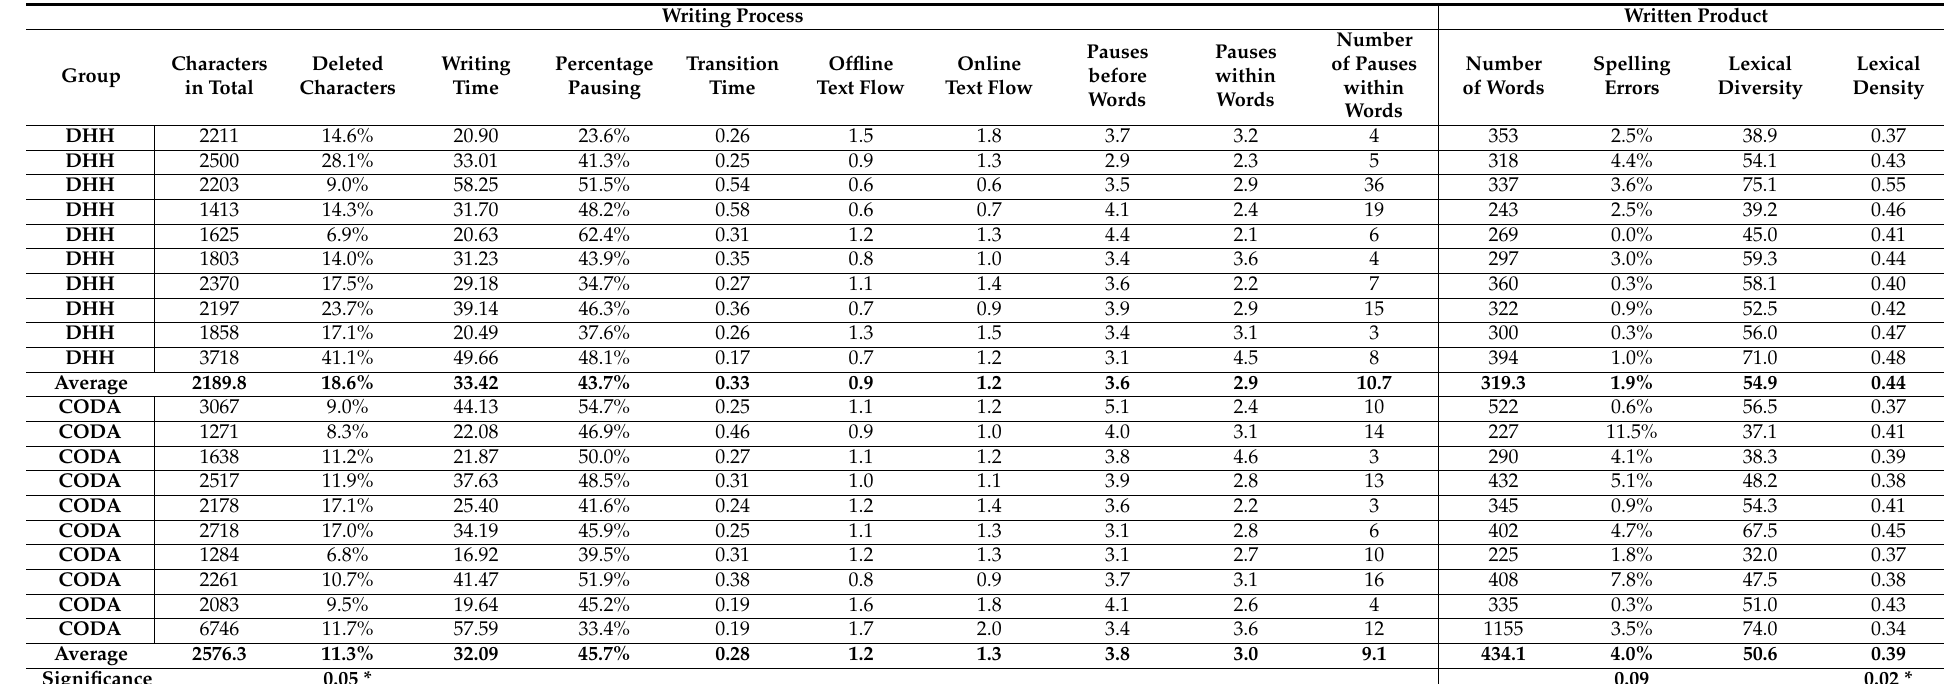
Table 4. The writing outcomes including writing process and written